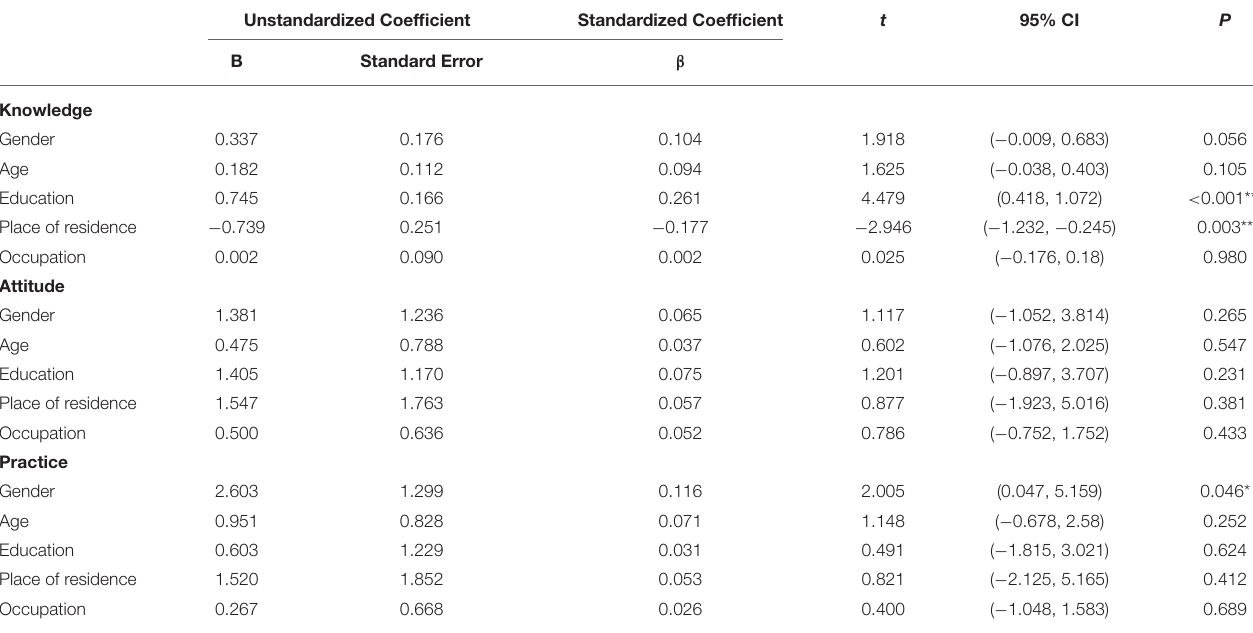
TABLE 5 | Multiple linear regression analysis of the factors influencing